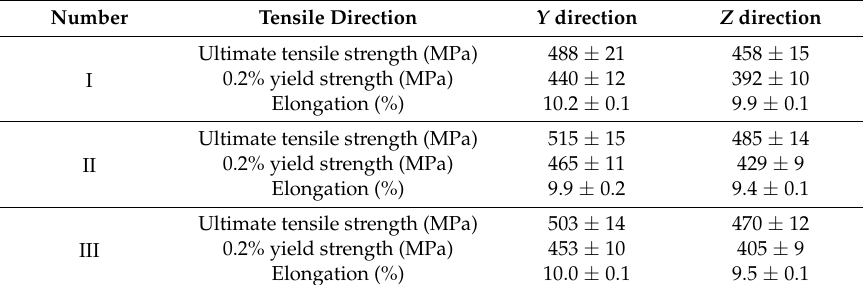
Table 5. Room-temperature tensile properties: I (CC 0.2 m/min), II (CC 0.3 m/min), and III (PC 0.2 m/min).